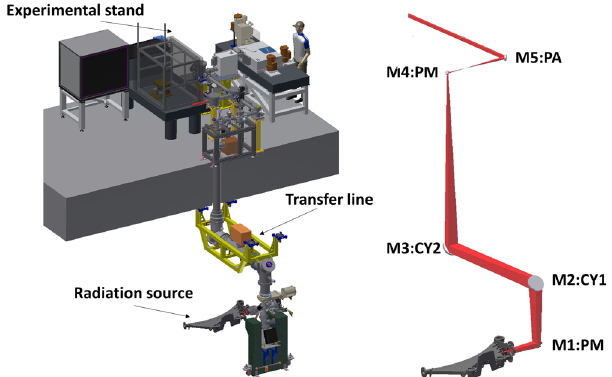
Fig. 4 Infrared (IR) beamline in metrology light source. This consists of M1:PM (plane mirror), M2:CY1 ( fi rst cylindrical mirror for focusing the light horizontally), M3:CY2 (second cylindrical mirror for focusing the light vertically), M4:PM (plane mirror), and M5:PA (parabolic mirror for collimating the light toward the experiments in both